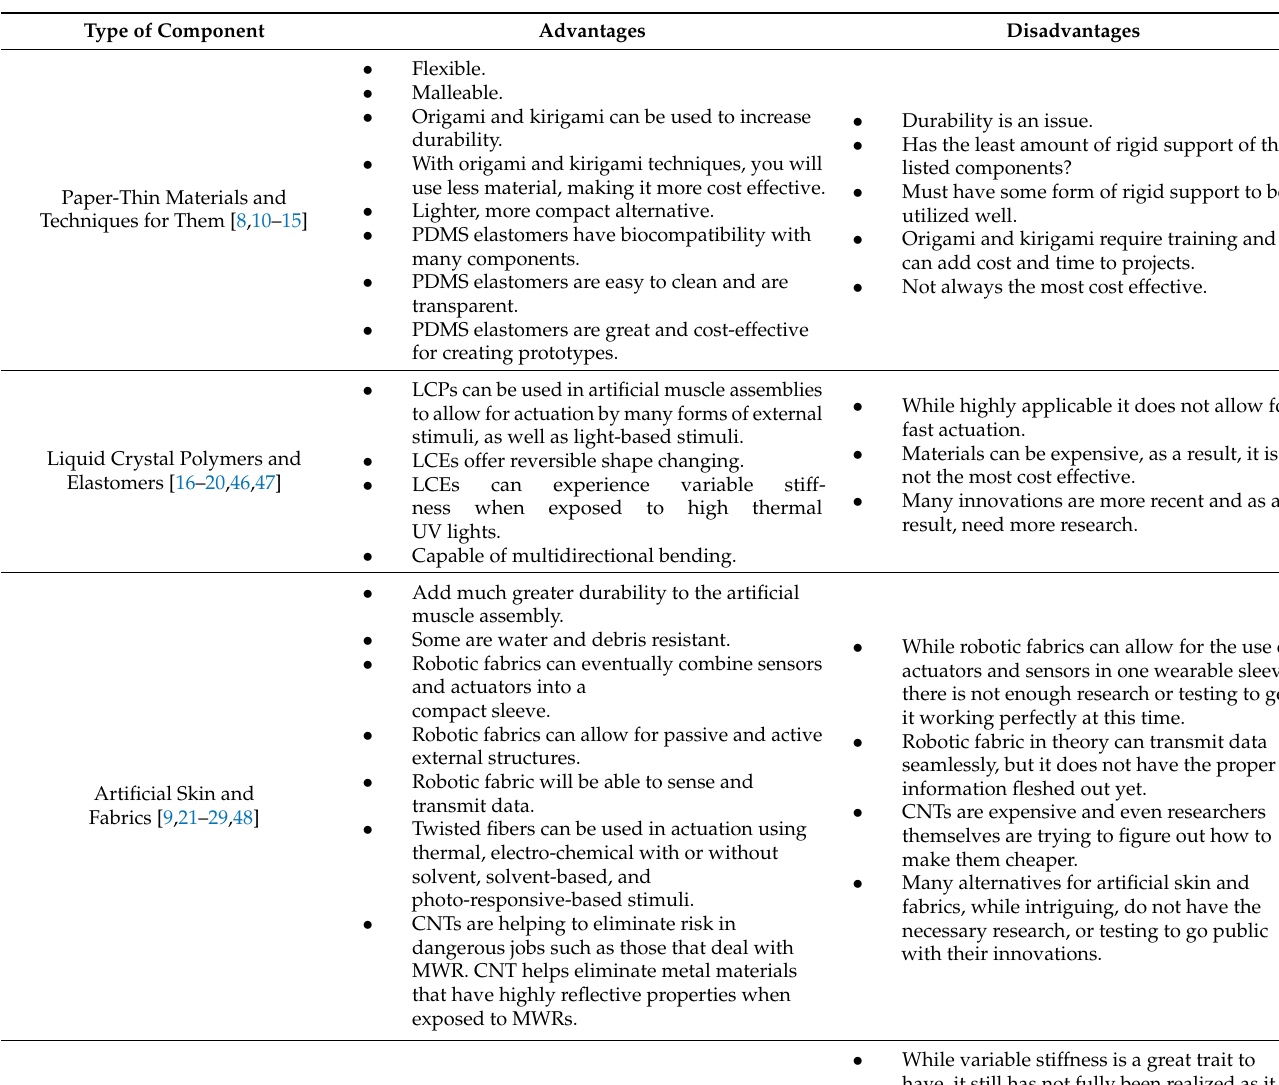
Table 1. Summary of each category of components and their advantages and